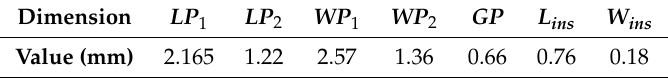
Figure 1. Geometry of the proposed dual-band (38/60 GHz) microstrip patch antenna. Table 1. Dimensions of the dual-patch microstrip patch antenna.